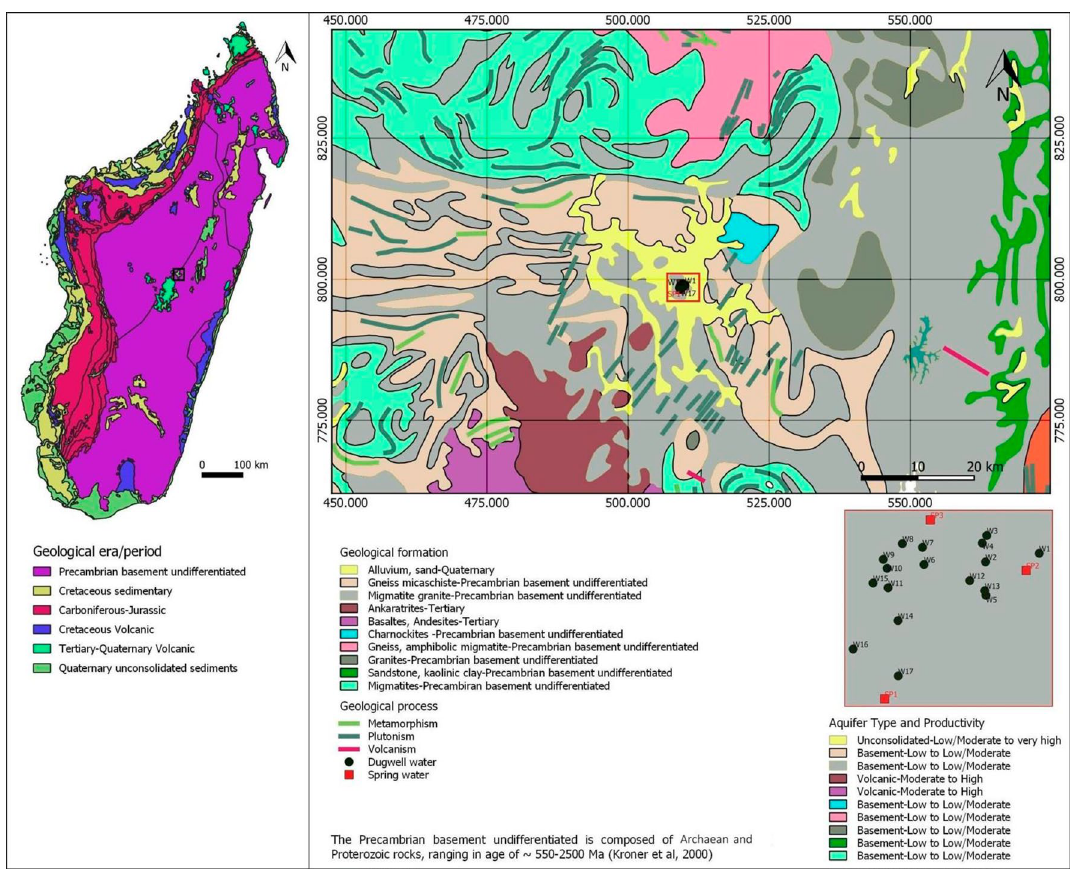
Fig. 2 Extract of the geology and hydrogeology of Antananarivo. Synthesis map. Source : GEOL500 database-Africa Groundwater